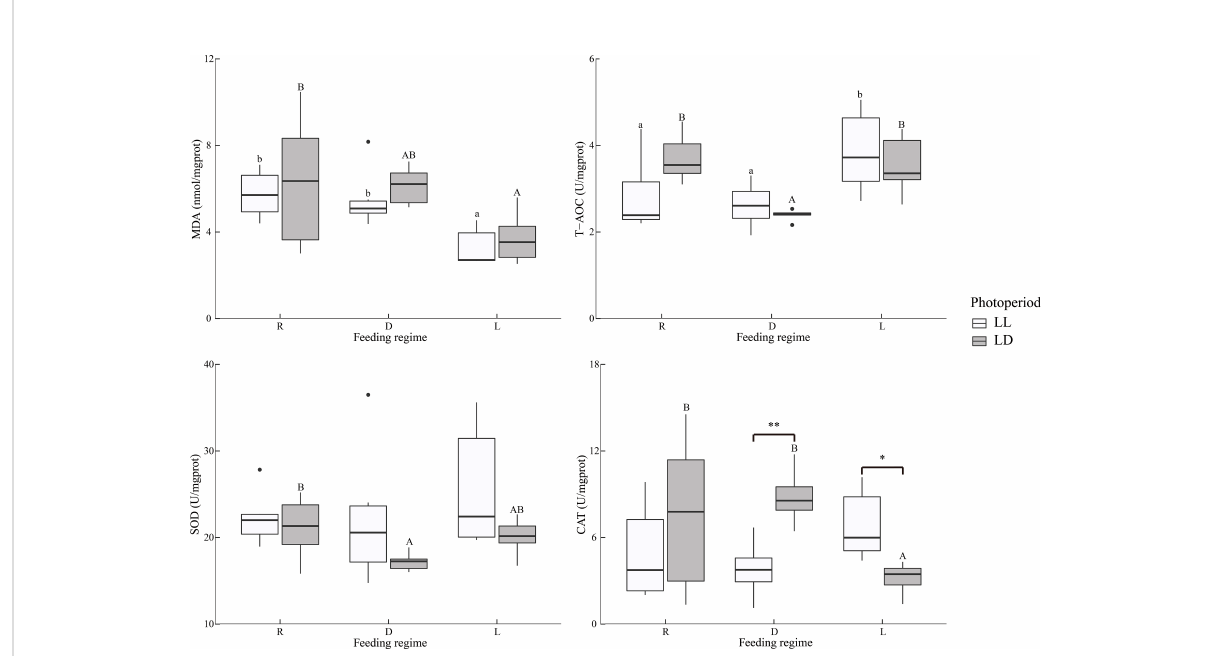
FIGURE 4 Intestine antioxidant indicators of juvenile Oncorhynchus mykiss under different experimental treatments (n=6). MDA: Malondialdehyde, T-AOC: Total antioxidant capacity, SOD: Superoxide dismutase, CAT, Catalase; R, random feeding; D, mid-dark stage feeding; L, mid-light stage feeding; LL: 24L: 0D, LD: 12L: 12D. Different lowercase letters and capital letters indicate signi fi cant difference among different feeding regimes at the LL (24L: 0D) and LD (12L: 12D, lights-on at 6:00), respectively ( P < 0.05). Asterisks denote signi fi cant differences between photoperiods at the same feeding regime (* P < 0.05; ** P < 0.01). Points outside the box plot are